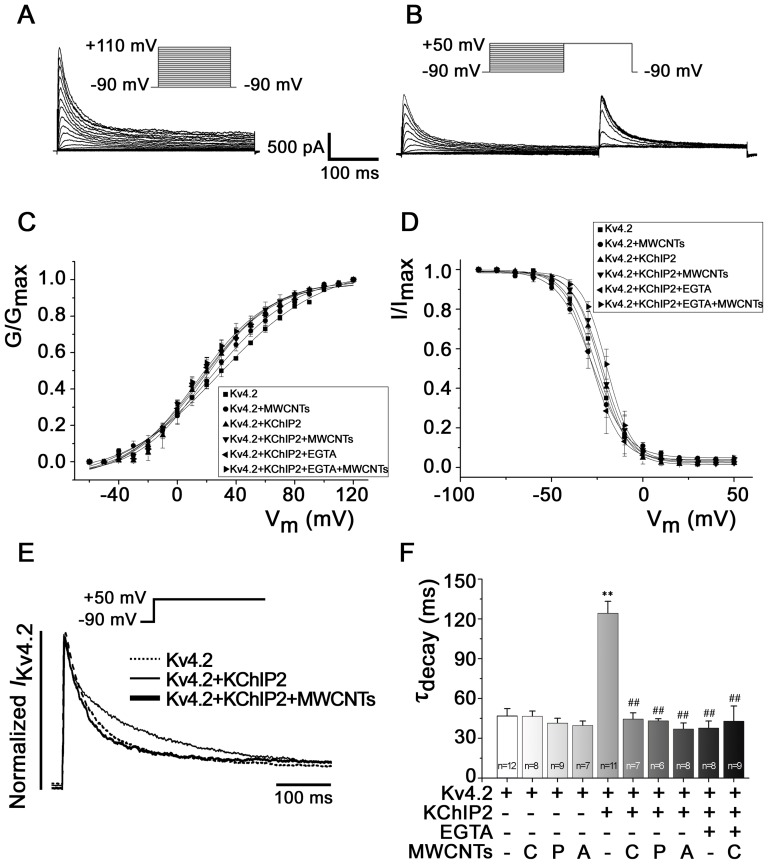
Effects of MWCNTs on the activation and inactivation kinetics of Kv4.2.
A and B, examples of activation (A) and inactivation (B) currents from transfected HEK293 cells. C and D, Boltzmann equation-fitted activation and inactivation curves, respectively. E, I
Kv4.2 obtained by depolarizing the cell from −90 mV to +50 mV, showing accelerated decay upon MWCNTs treatment in HEK293 cells co-expressing Kv4.2 with KChIP2. F, statistical data of decay time constants (τdecay) in various conditions. Abbreviations: C, carboxylated MWCNTs; P, pristine MWCNTs; A, aminated MWCNTs. **
P<0.01 vs. Kv4.2. ##
P<0.01 vs. KChIP2.